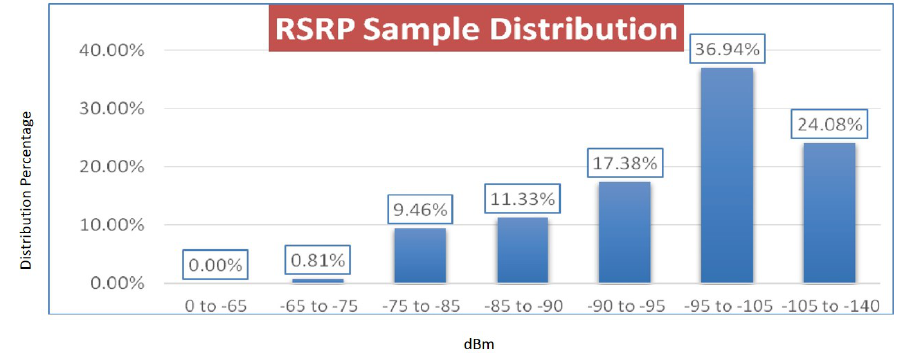
Figure 6. The reference signal received power (RSRP) efficiency for our tested scenarios distribution percentage.